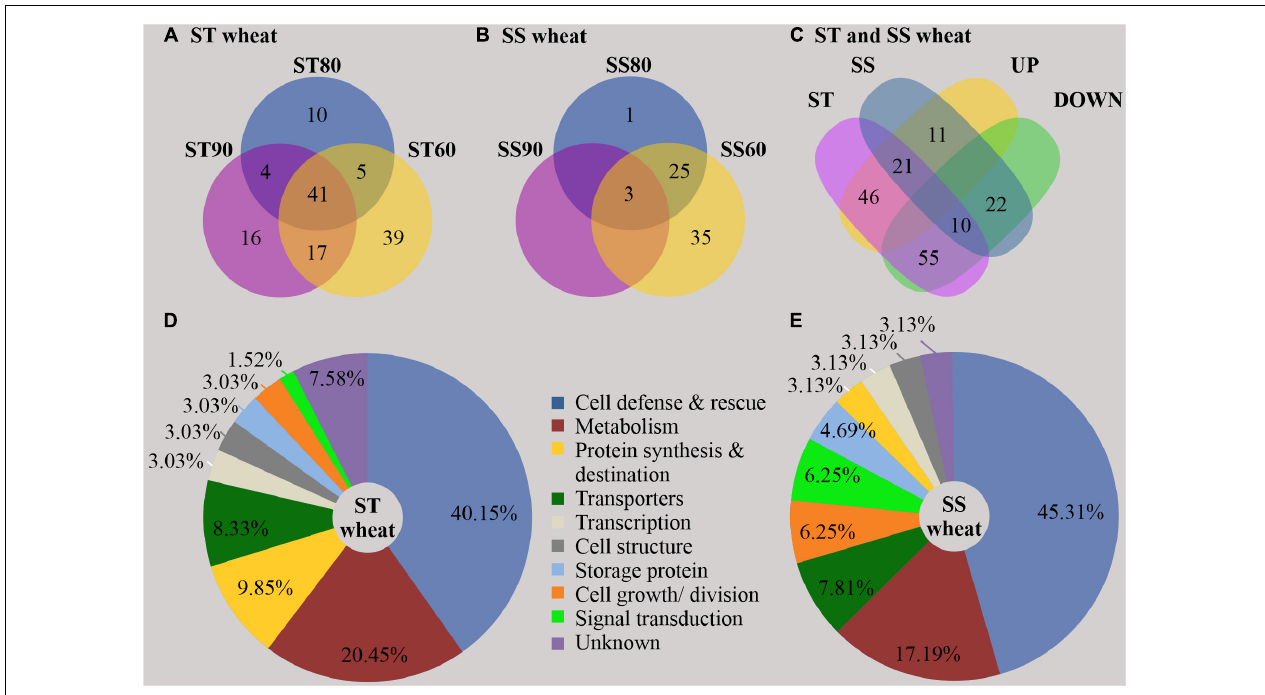
FIGURE 3 | Distribution and function of differentially abundant proteins (DAPs) resulting from artificial aging treatment of storage-tolerant (ST) and storage-sensitive (SS) seed. The Venn diagram shows the distribution of DAPs in ST (A) and SS (B) embryos around (SS90/ST90 and SS60/ST60) and close to the critical node (SS80/ST80 and their intersection) (C) . The Pie chart shows the functional classification according to Bevan et al. (1998) and Zhang et al. (2016). 132 DAPs were found in imbibed embryos of ST seeds (D) , and 64 DAPs in imbibed embryos of SS seeds (E) . % is given of the total number of proteins in ST and SS embryos, respectively, UP, upregulated DAPs; and DOWN, downregulated